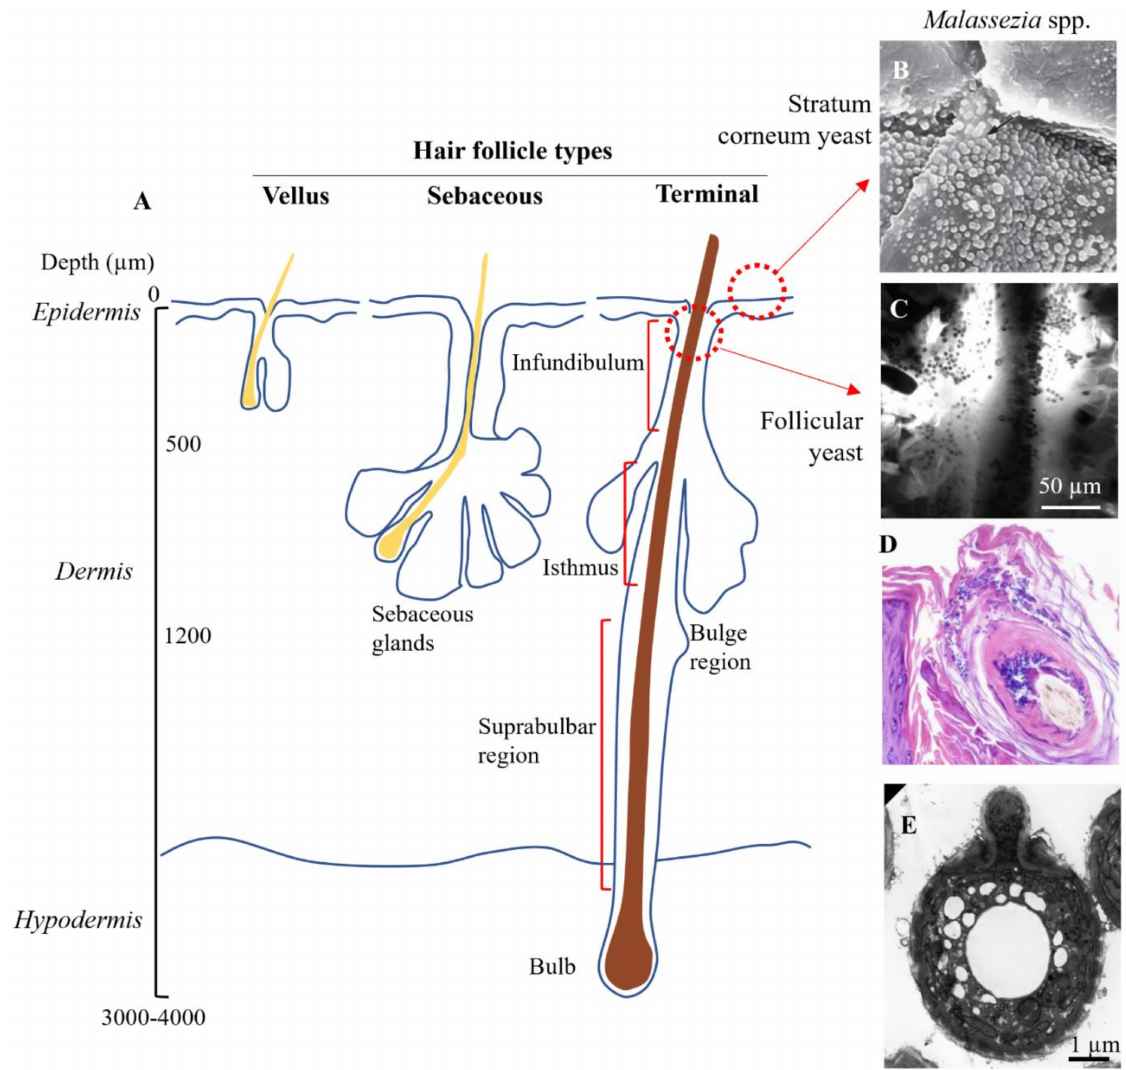
Figure 4. Target sites for topical zinc pyrithione. ( A ) Schematic showing anatomy of the three different types of hair follicle. ( B ) Surface colonization of Malassezia yeast ( × 2700 magnification). Pi é rard et al. (2006), reproduced with permission [117]. ( C ) Yeast colonization in the infundibulum imaged using in vivo confocal microscopy. Meyer et al. (2005), reproduced with permission [119]. ( D ) Yeast congregating and spreading within epithelial cells of the hair follicle ( × 20 magnification), reproduced from [124] in accordance with StatPearls Publishing LLC Creative Commons Attribution 4.0